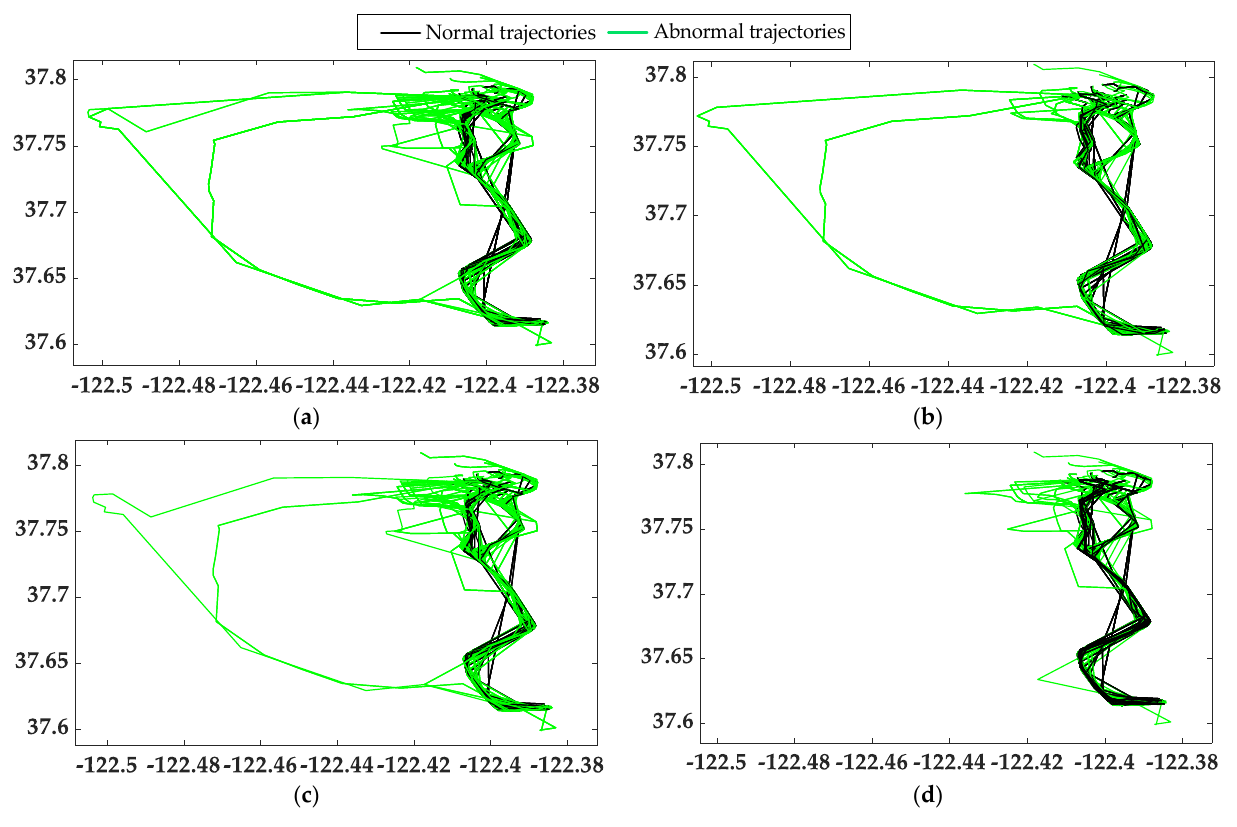
Figure 9. Visualization of ATDVG results: ( a ) T-1; ( b ) T-2; ( c ) T-3; ( d ) T-4.